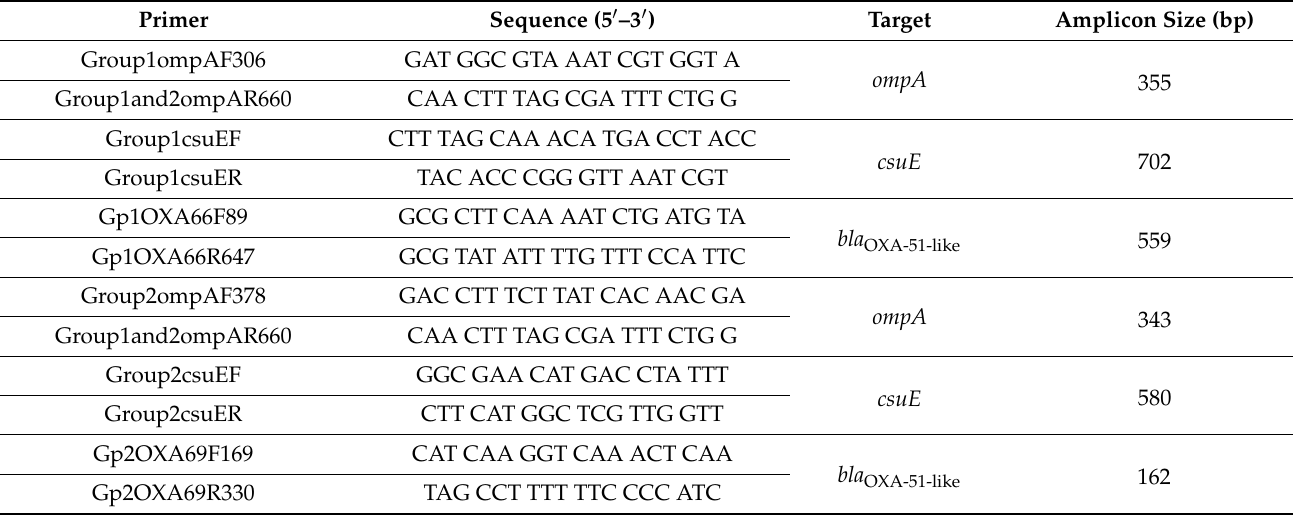
Table 3. Primers used in multiplex PCRs for identification of international clonal